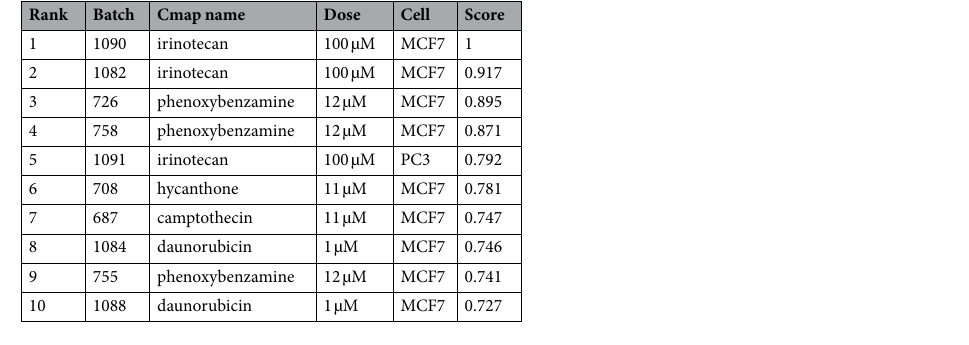
Table 2. Top CMAP analysis of nitidine chloride in detailed